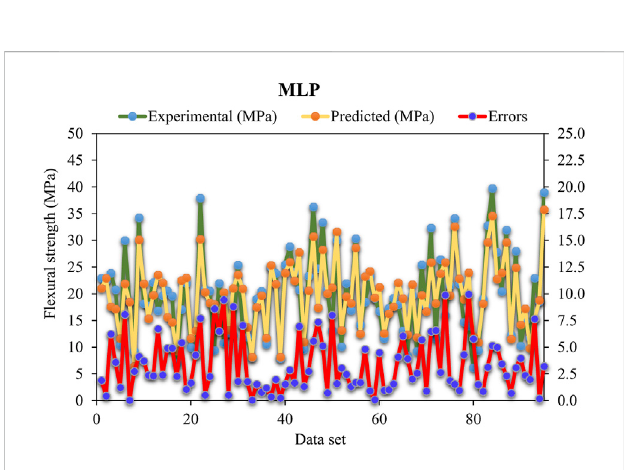
FIGURE 11 Difference of errors among actual and predicted UHPC FS — MLP model.